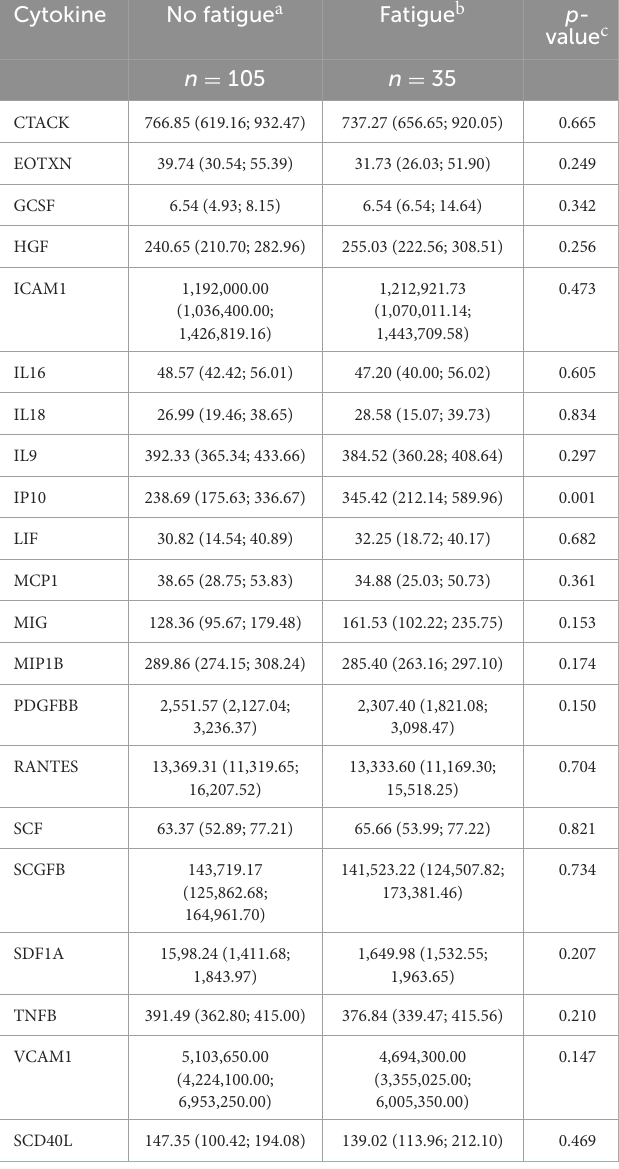
TABLE 3 Serum levels of cytokines (pg/ml; median, 25% quantile; 75% quantile) in 140 individuals with and without fatigue in the “Metabolism, Nutrition and Immune System in Augsburg” (MEIA)